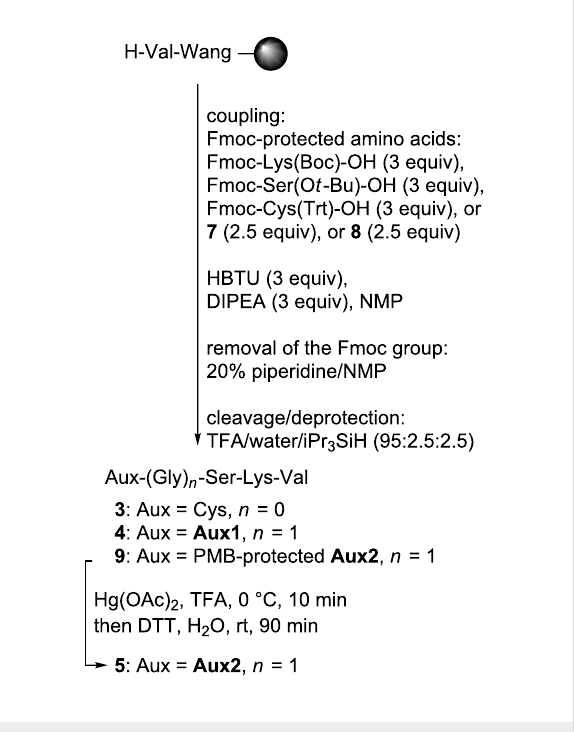
Scheme 2: Solid-phase synthesis of the ligation-mediating peptides 3 – 5